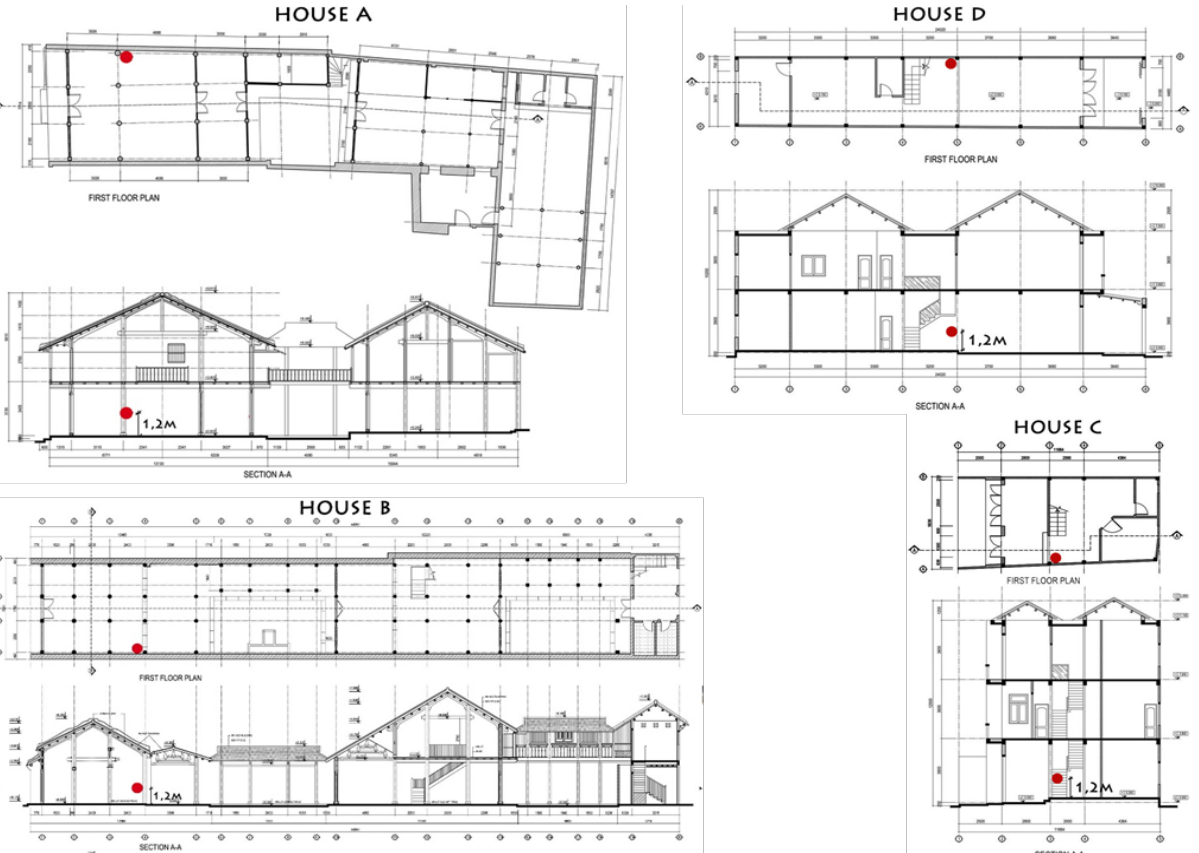
Figure 8. Location of temperature measuring devices in four surveyed